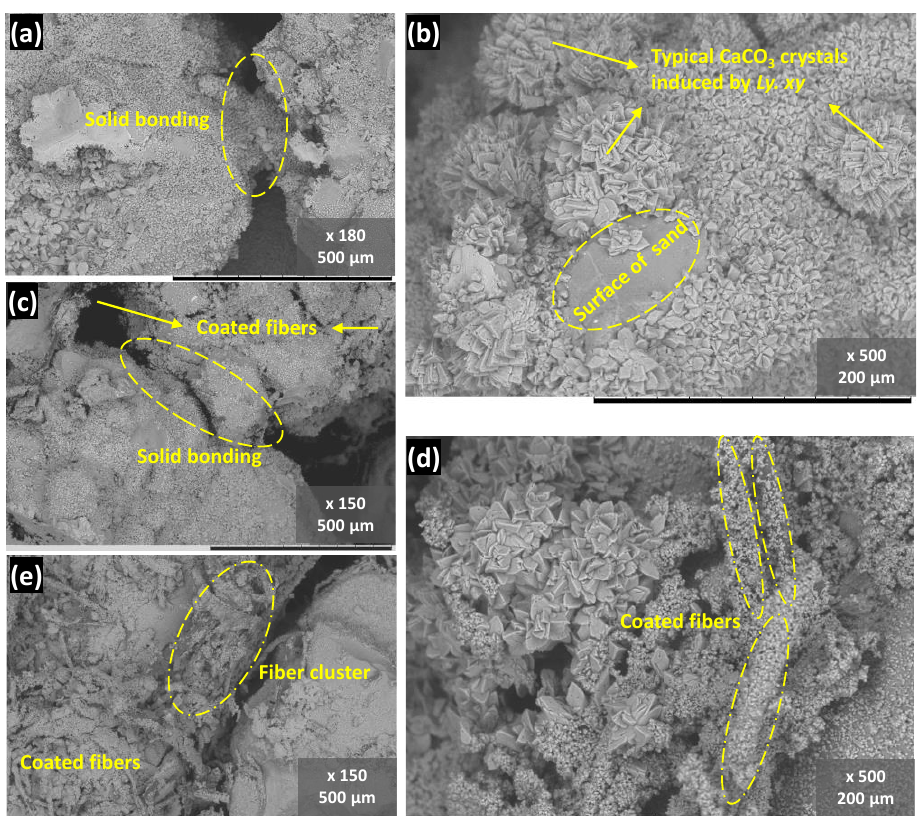
Figure 11. SEM images of representative MICP-treated samples with ( a , b ) 0%; ( c ) 1%; ( d ) 2%; and ( e ) 4% of fiber content.